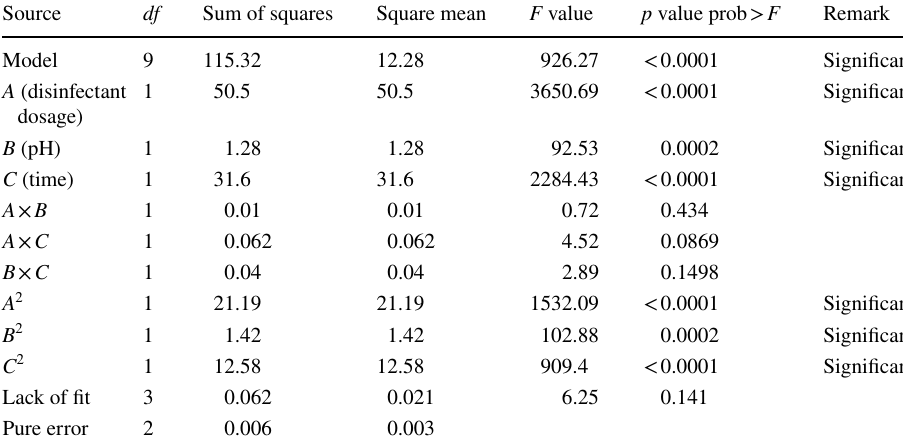
Table 3 Analysis of variance for the response rate of Escherichia coli